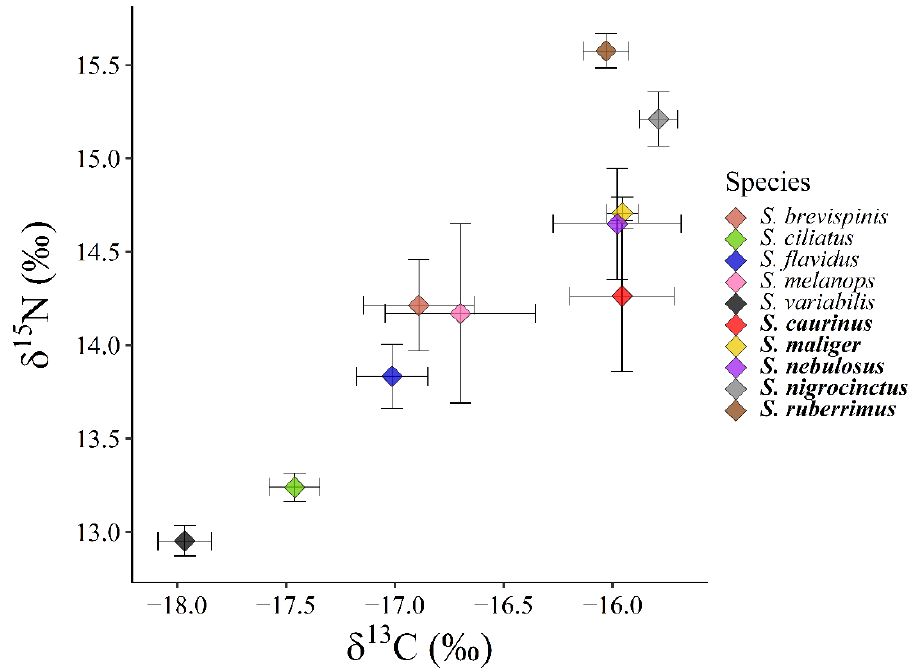
Figure 1. Mean isotopic δ values and 95% confidence intervals for ten rockfish species from southeast Alaska. Species names in bold font are demersal and non-bold names are pelagic. The five species of pelagic rockfish are less than − 16.5‰ δ 13 C and the five species of demersal rockfish are greater than − 16.5‰ δ 13 C.